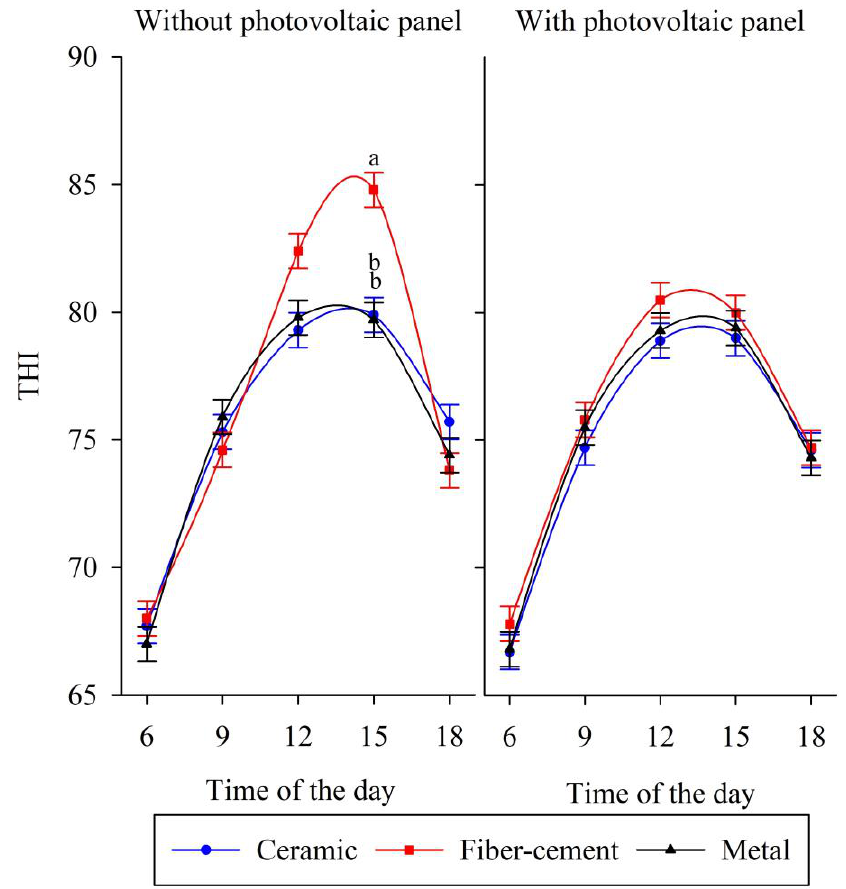
Figure 7. Behavior of the temperature and humidity index (THI) and the unfolding of the interaction between the three types of tiles analyzed within the hours, with and without photovoltaic panel. The different letters are statistically different, with the absence of a letter there were no significant differences.